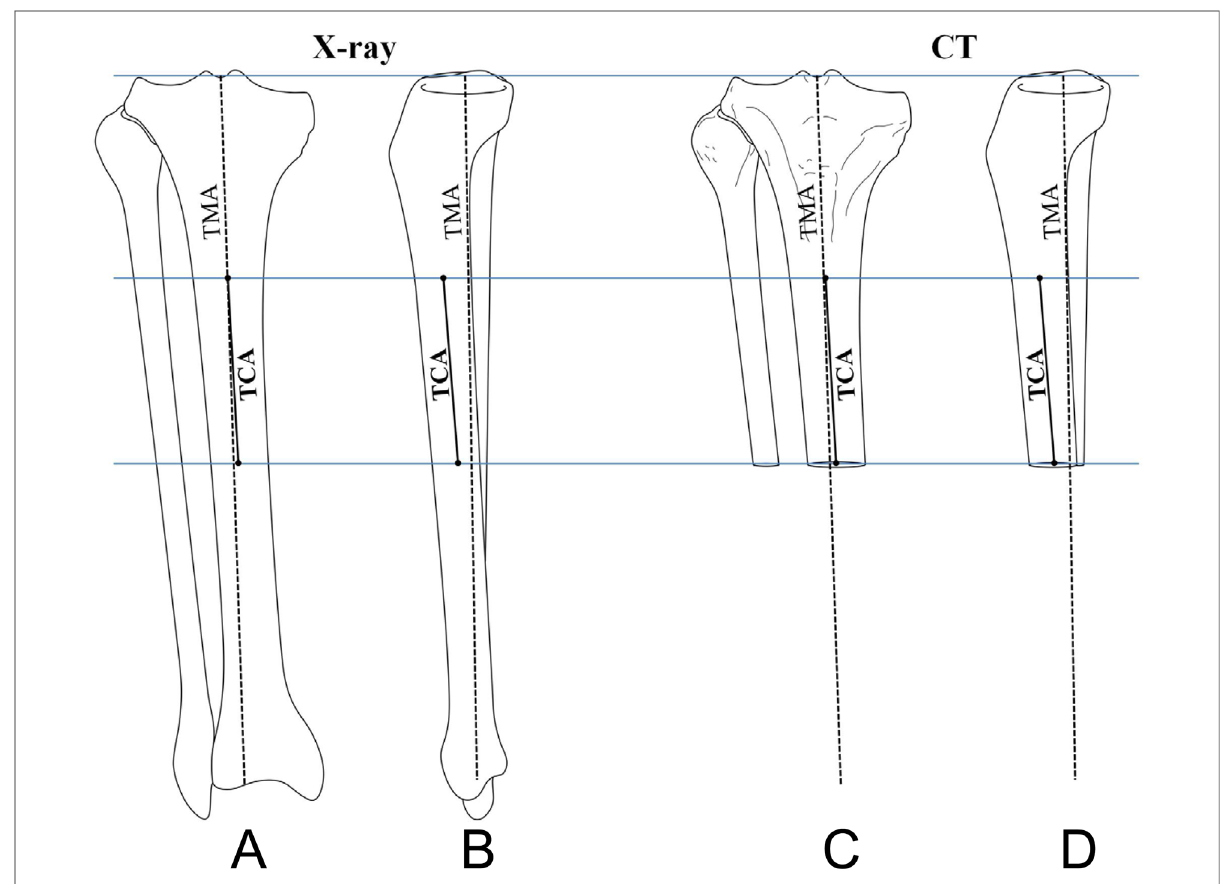
FIGURE 2 A uniform 4-step method was used to de fi ne the tibial mechanical axis (TMA) on 3D CT models. Step 1: TMA was drawn on both the AP and lateral views of the full-length radiographs ( A,B ). Step 2: The TCA of the proximal tibia was de fi ned as a line connecting the centers of the canal at two distant levels. Then, the TCA was copied from the full-length radiographs to 3D CT models based on the same levels ( C,D ). Step 3: The intersection angles was measured between the TMA and the TCA both on the AP and lateral views of the full-length radiographs ( A,B ). Step 4: On 3D CT models, the TMA was de fi ned based on the measured intersection angles and the copied TCA ( C,D